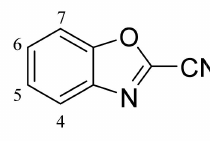
Figure 1. Structure of benzoxazole-2-carbonitrile with numbering of possible positions of substituents